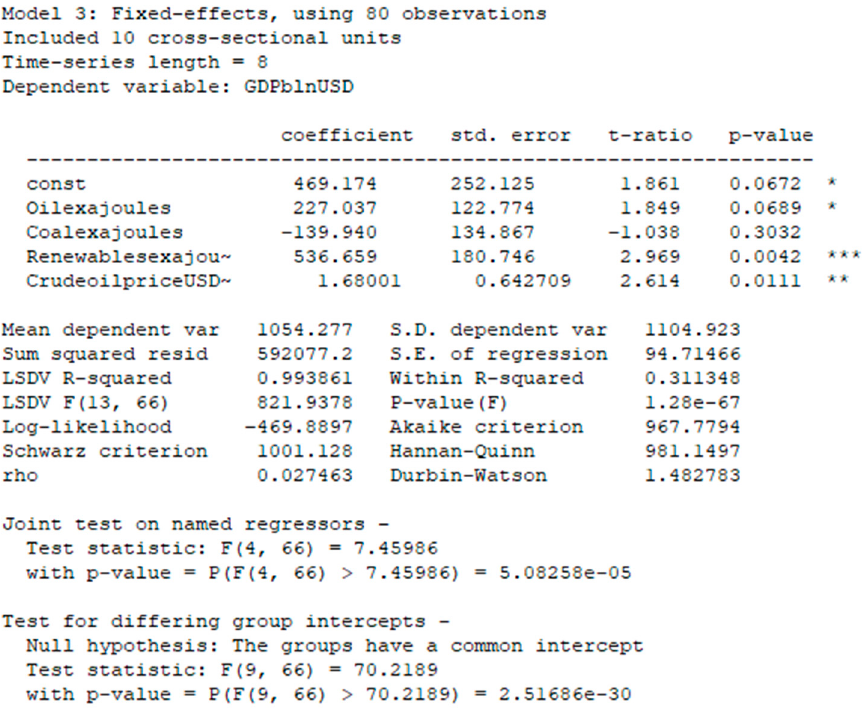
Figure 6. Compare Fixed Effects and Pooled regression models. We tested the Fixed Effects model using the Joint test on named regressors. p -value = 5.08258 × 10 − 5 —the value was very small compared with the alpha value, so we chose the Fixed effects model from these two